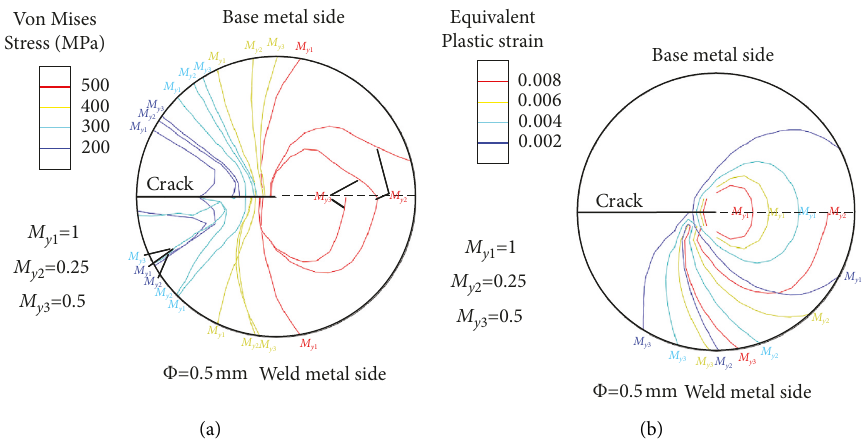
Figure 8: Contour of the sandwich structure welded joint model whose yield strength changes in the y -direction. (a) Von Mises stress contour at crack tip. (b) Equivalent plastic strain contour at crack